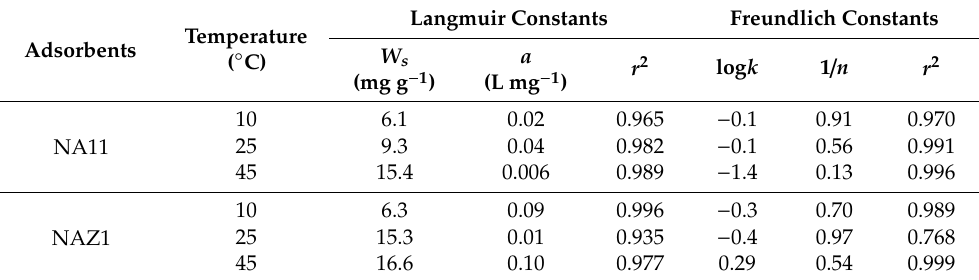
Figure 6. E ff ect of temperature on the adsorption of As(III) using NA11 ( A ) and NAZ1 ( B ). Initial Figure 6. Effect of temperature on the adsorption of As(III) using NA11(A) and NAZ1(B). Initial concentration 1, 10, 30, 50, 70, and100 mg L − 1 , solvent volume 50 mL, adsorbent 0.1 g, contact time 24 h, concentration 1, 10, 30, 50, 70, and100 mg L −1 , solvent volume 50 mL, adsorbent 0.1 g, contact time 24 pH 5.5-6.4 and 5.9-6.2 for NA11 and NAZ1, temperature 10 ( • ), 25 ( • ), and 45 ◦ C ( • ), agitation speed 100 rpm. Table 3. Langmuir and Freundlich constants for the adsorption of